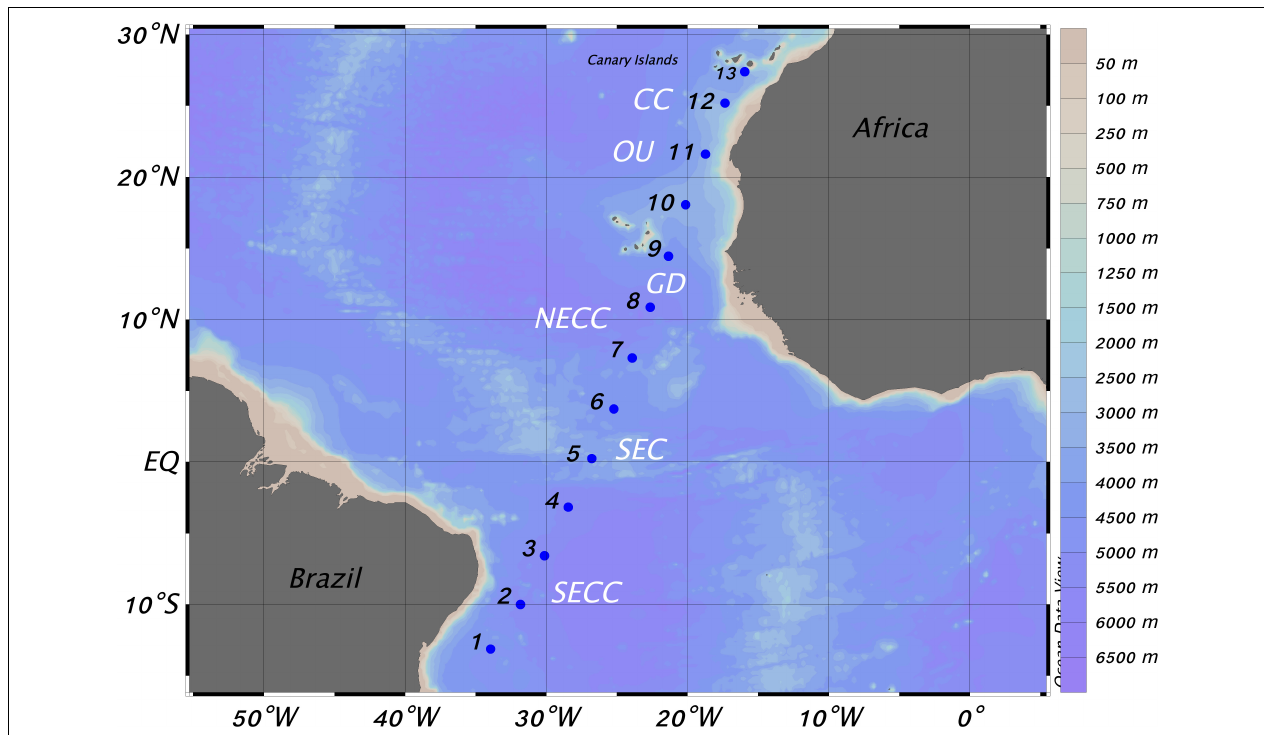
FIGURE 1 | Location of stations carried out in the tropical and subtropical Atlantic Ocean during the Mafia Cruise. CC, Canary Current; OU, Oceanic Upwelling; GD, Guinea Dome; NECC, North Equatorial Counter Current; SEC, South Equatorial Current; SECC, South Equatorial Counter Current (see